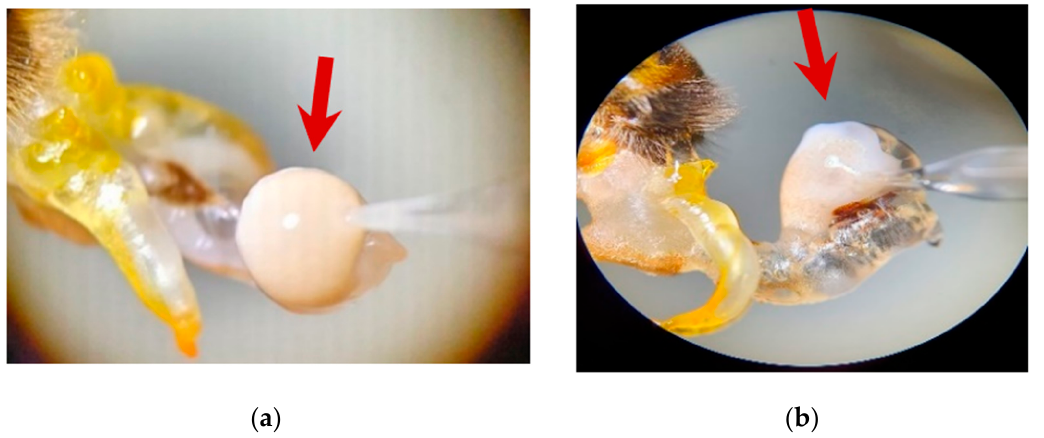
Figure 1. Semen collection from ( a ) spherical ejaculate or ( b ) dispersed, amorphous ejaculate.